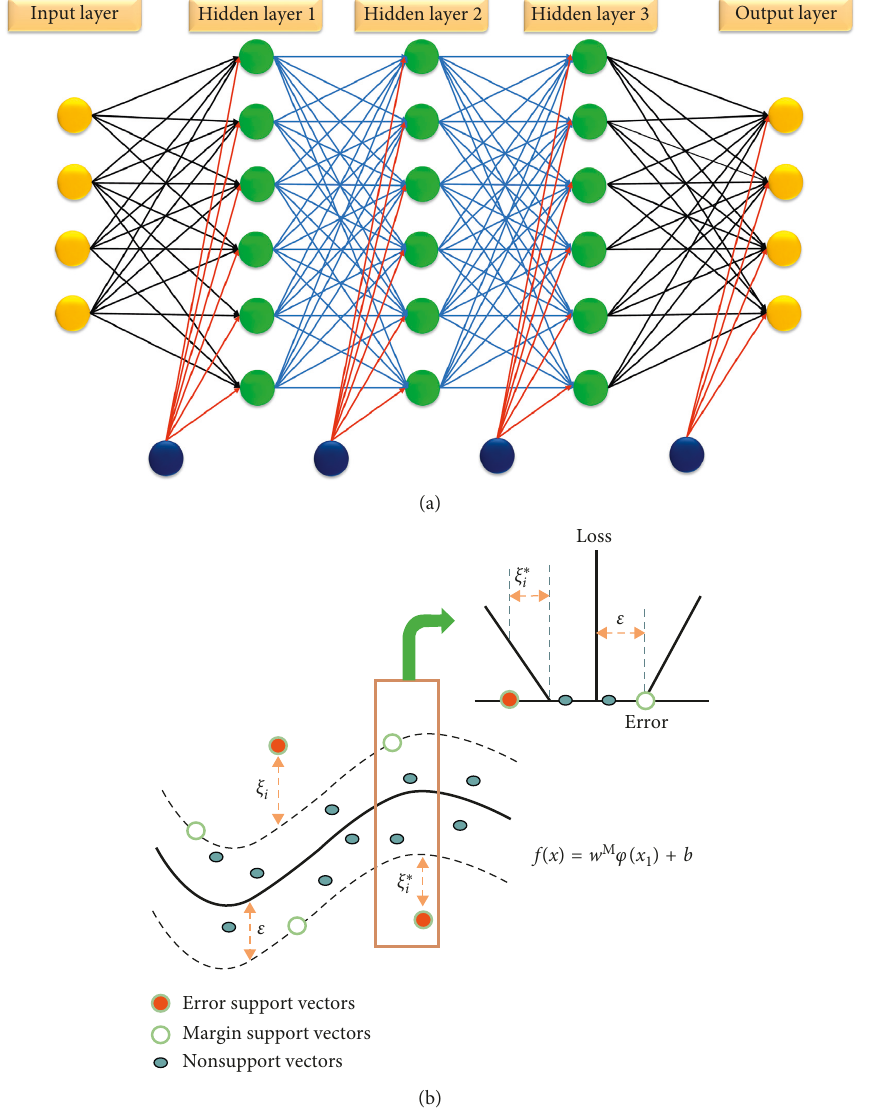
Figure 2: (a) The slandered architecture of deep neural network description and (b) the support vector regression model